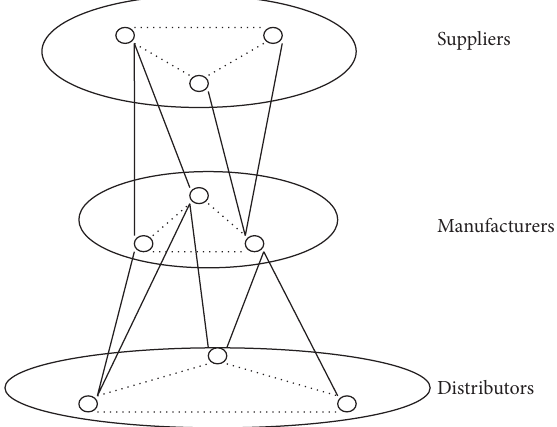
Figure 2: Network structure of cluster supply